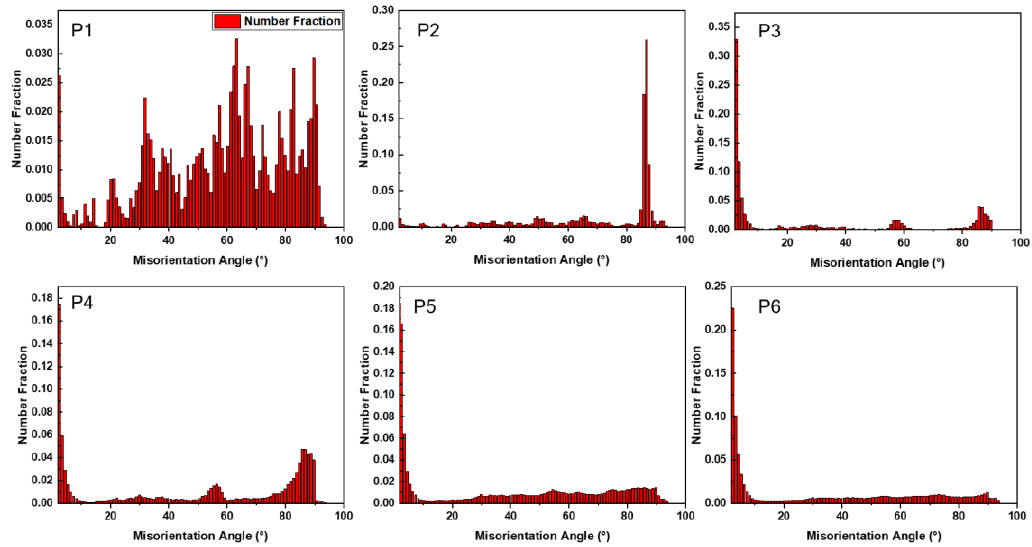
Figure 11. The misorientation angle at P1, P2, P3, P4, P5, and P6.